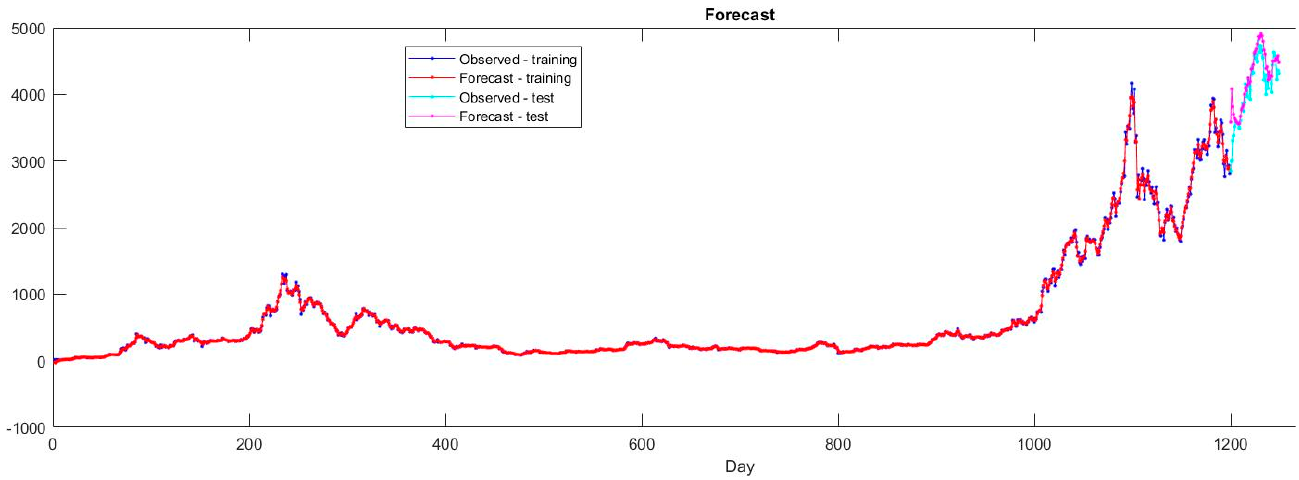
Figure 23. ETH–USD: ES-LSTM training.